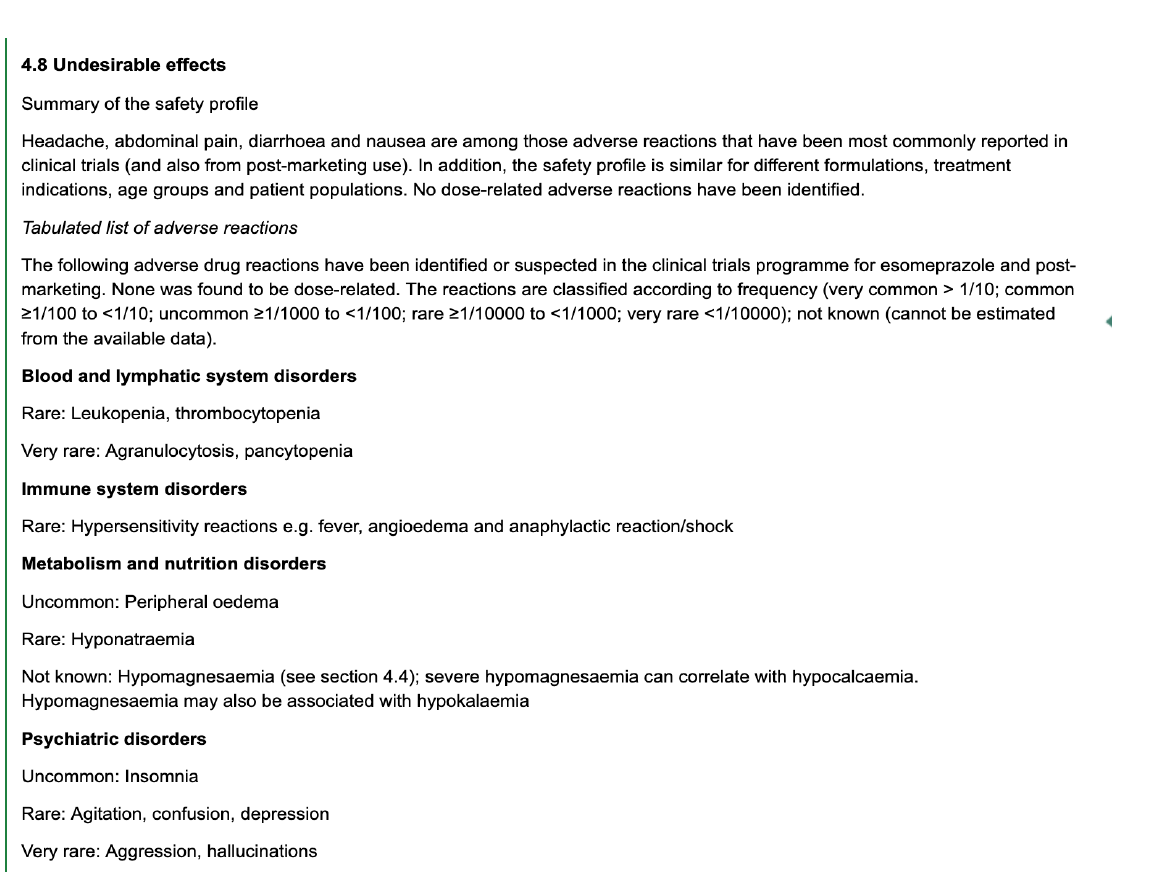
Figure 1. A conceptual overview of the automatic Adverse Drug Reactions (ADRs) extraction pipeline.